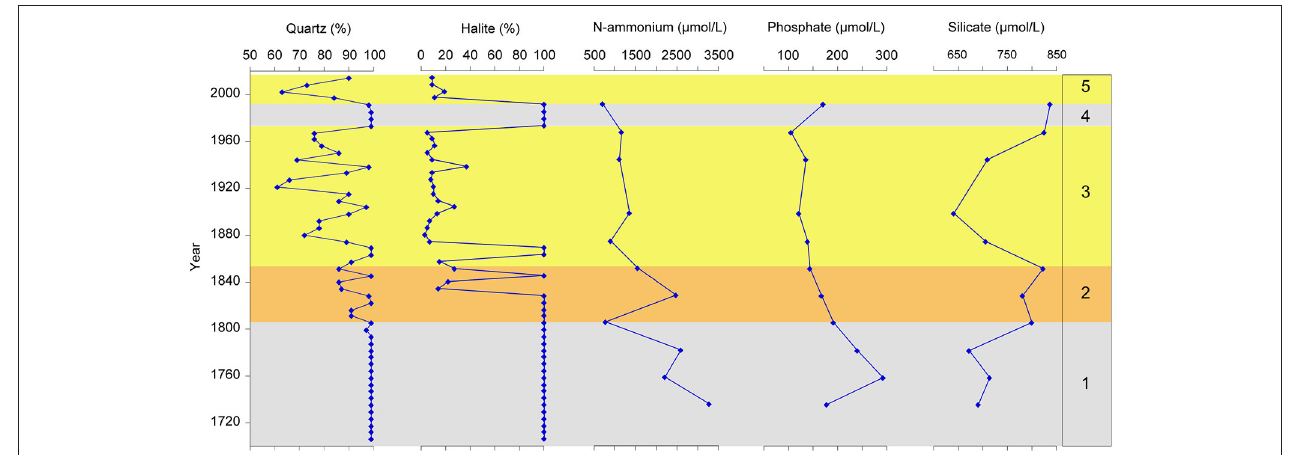
FIGURE 9 | Major mineral concentrations and pore water results over time for core CAN-N-01. Dating before 1850 has been extrapolated from the sedimentation rate. (1) Period before the construction of the Valo Grande channel; (2) Period during the construction of the Valo Grande channel; (3) Period during which the Valo Grande channel was completely open; (4) Period of the closure of the Valo Grande channel with a dam; (5) Period after the destruction of the dam and complete re-opening of the Valo Grande channel.